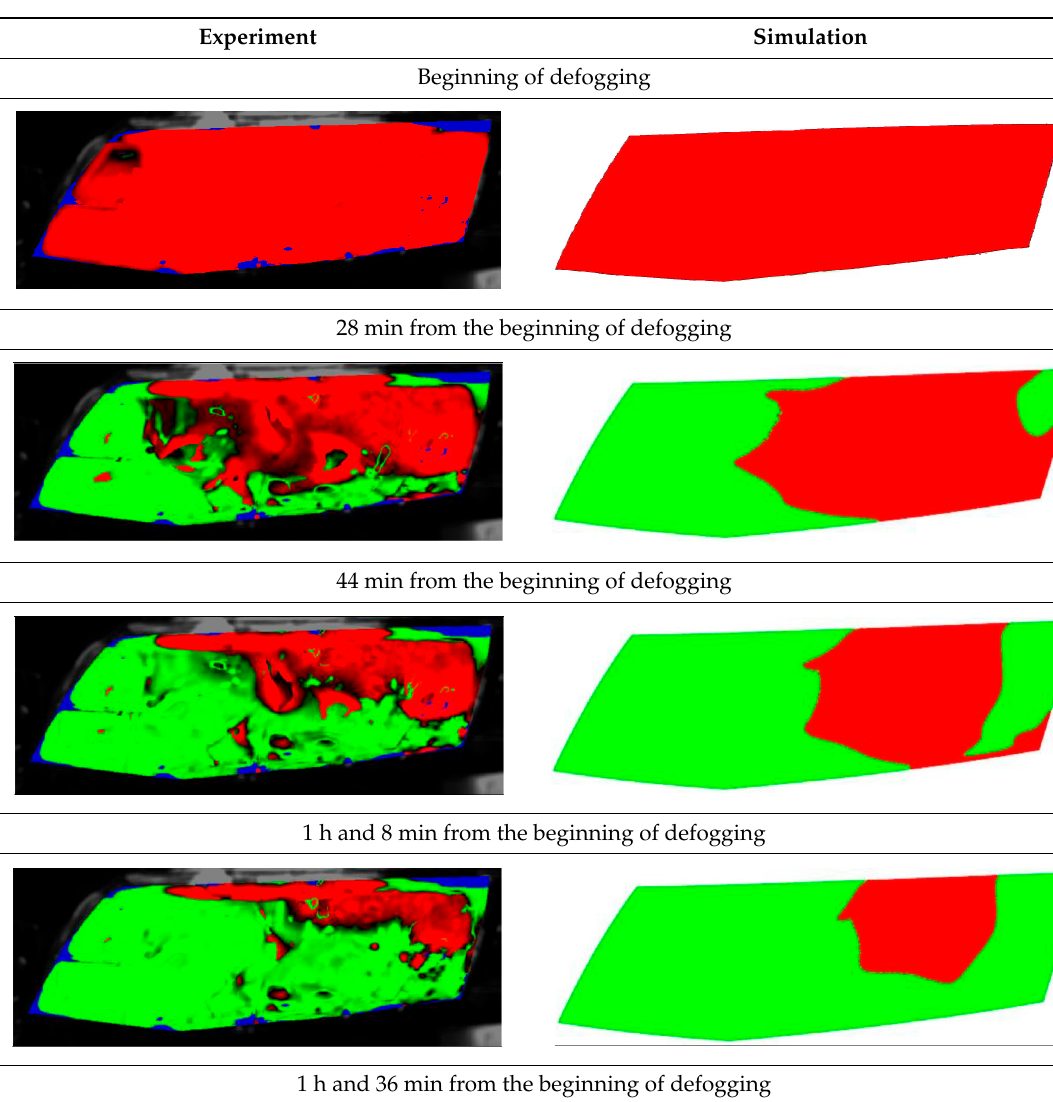
Table 9. Visual comparison of C1.5 results (red—fogged, green—defogged, blue—unevaluable).